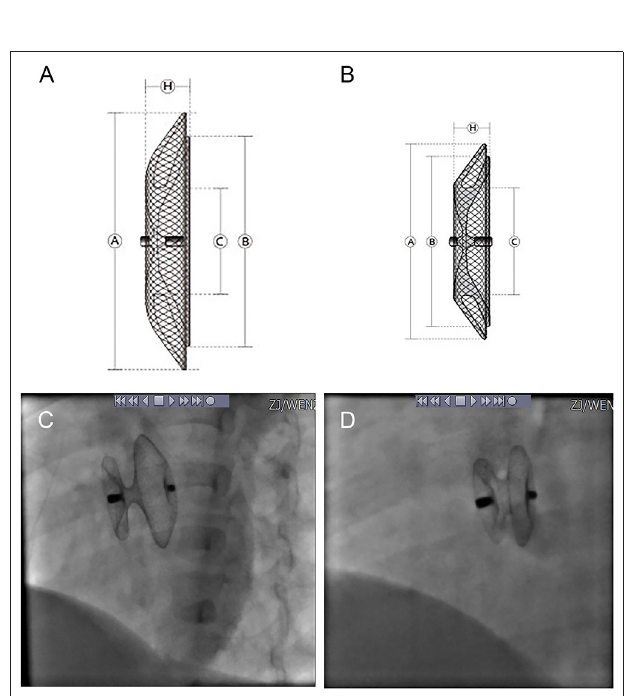
FIGURE 2 | Product structure diagram and DSA image diagram of small-waist–big-edge (A,C) and standard (B,D) ASDO. ASDO, atrial septal defect occluder; ASA, atrial septal aneurysm.